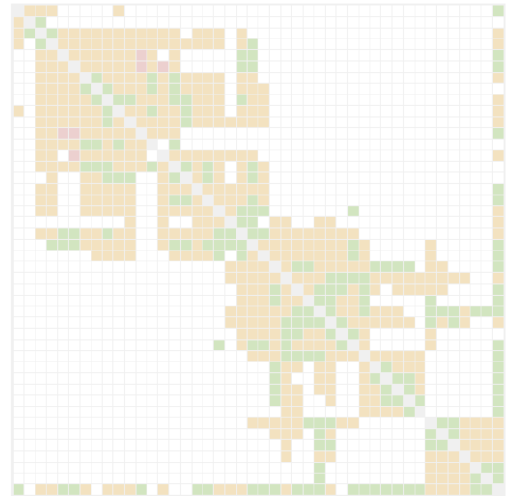
Table 2. Case Study 2: statistics on the differences of scan locations computed with two registration